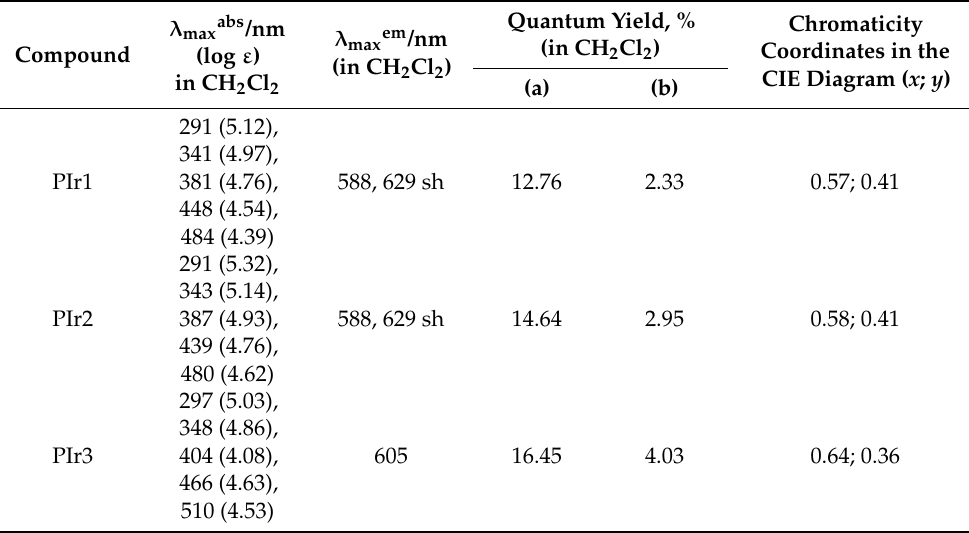
Table 1. Photophysical characteristics of PIr1–PIr3 in CH 2 Cl 2 solution.